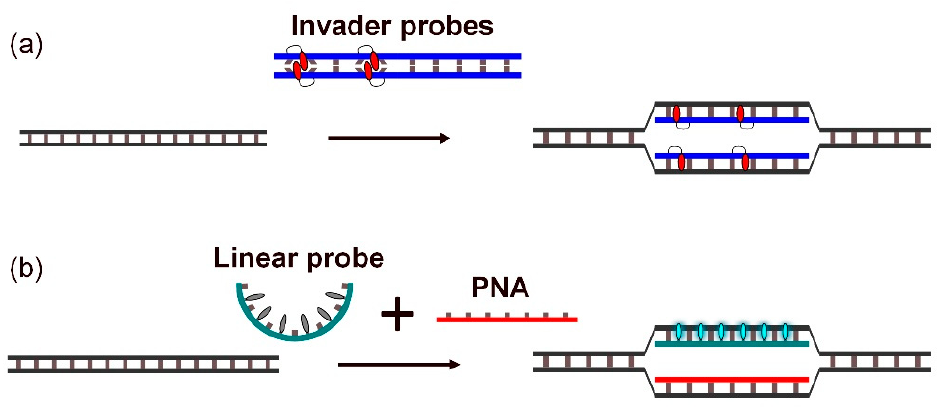
Figure 13. Sequence-selective recognition of dsDNA with ( a ) invader probes and ( b ) a combination of linear probe and unmodified PNA.